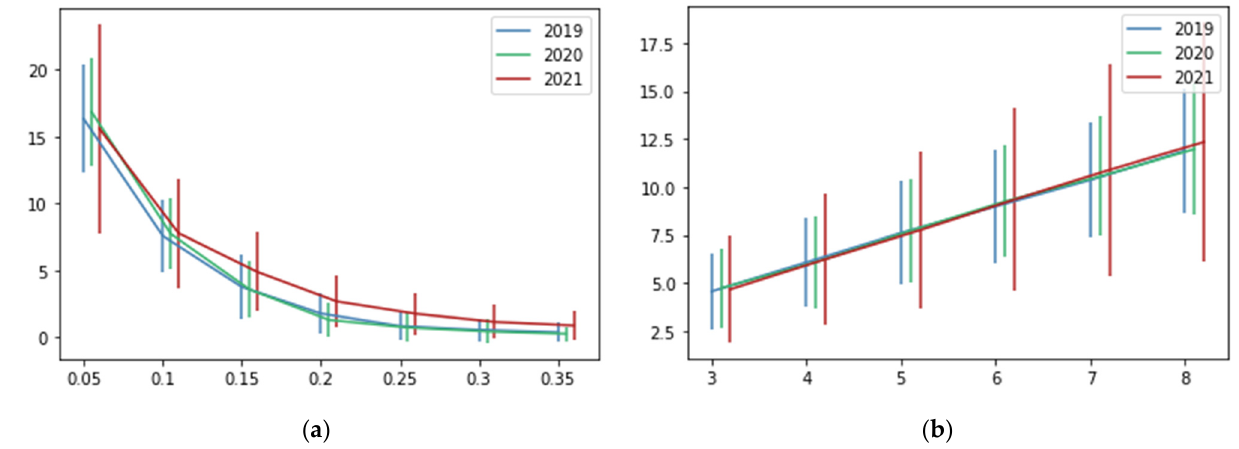
Figure 7. Percentage of correct recommendations ( y -axis) in a scale from 0 to 1, according to the values of the parameters ( x -axis). Vertical lines represent the standard deviation. ( a ) Testing differ- ent values for pmin , k = 5. ( b ) Testing different values for k , pmin = 0.1.